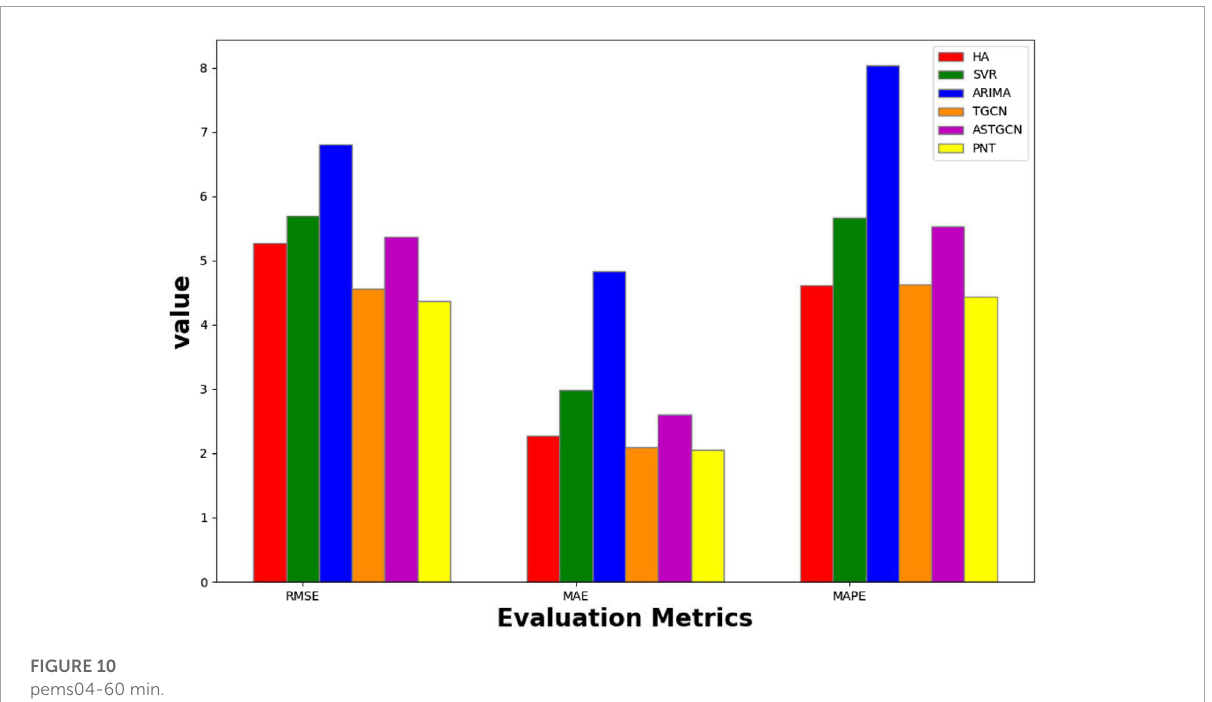
FIGURE 10 pems04-60 min.